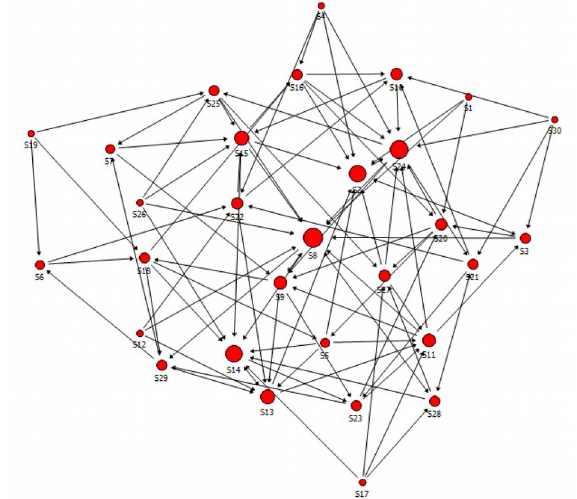
Figure 1. Relationships Maps of